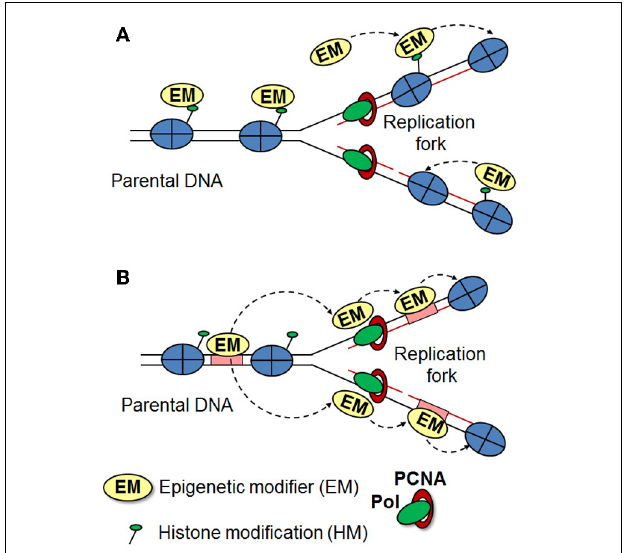
FIGURE 1 | Inheritance of histone modification patterns. Two models for the maintenance of histone modifications are presented, which may apply in different organisms and cellular contexts. (A) Modified histones are evenly distributed between the daughter strands during replication, where they act as a template for further recruitment of histone modifiers to reestablish the original epigenetic state. (B) During replication, modified histones are rapidly replaced by unmethylated histones. Epigenetic modifiers (such as TrxG and PcG) remain stably associated with their binding elements (or other factors) during the progression of the replication fork and re-establish the histone modification patterns onto the newly deposited